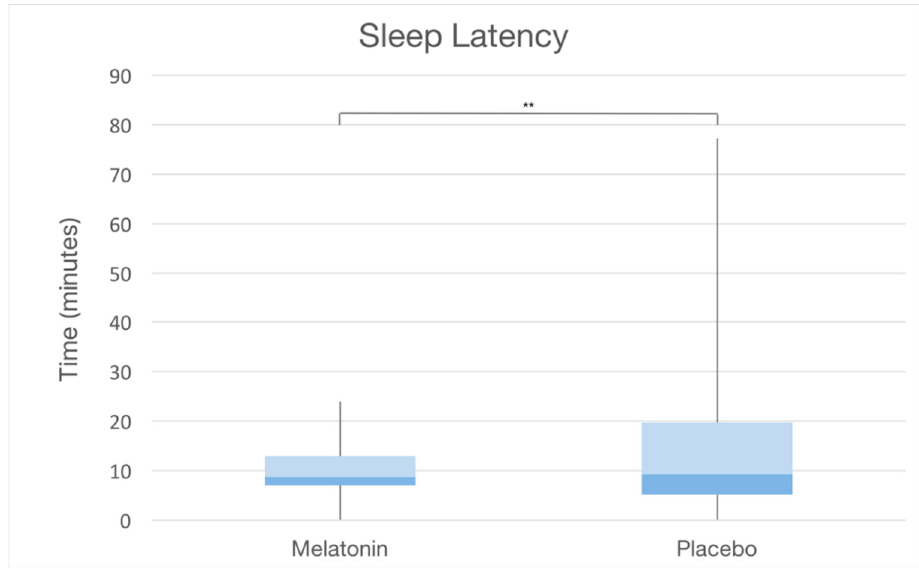
Figure 3. Box plot showing overall differences in sleep latencies between MG and CG. ** p- value : 0.002.